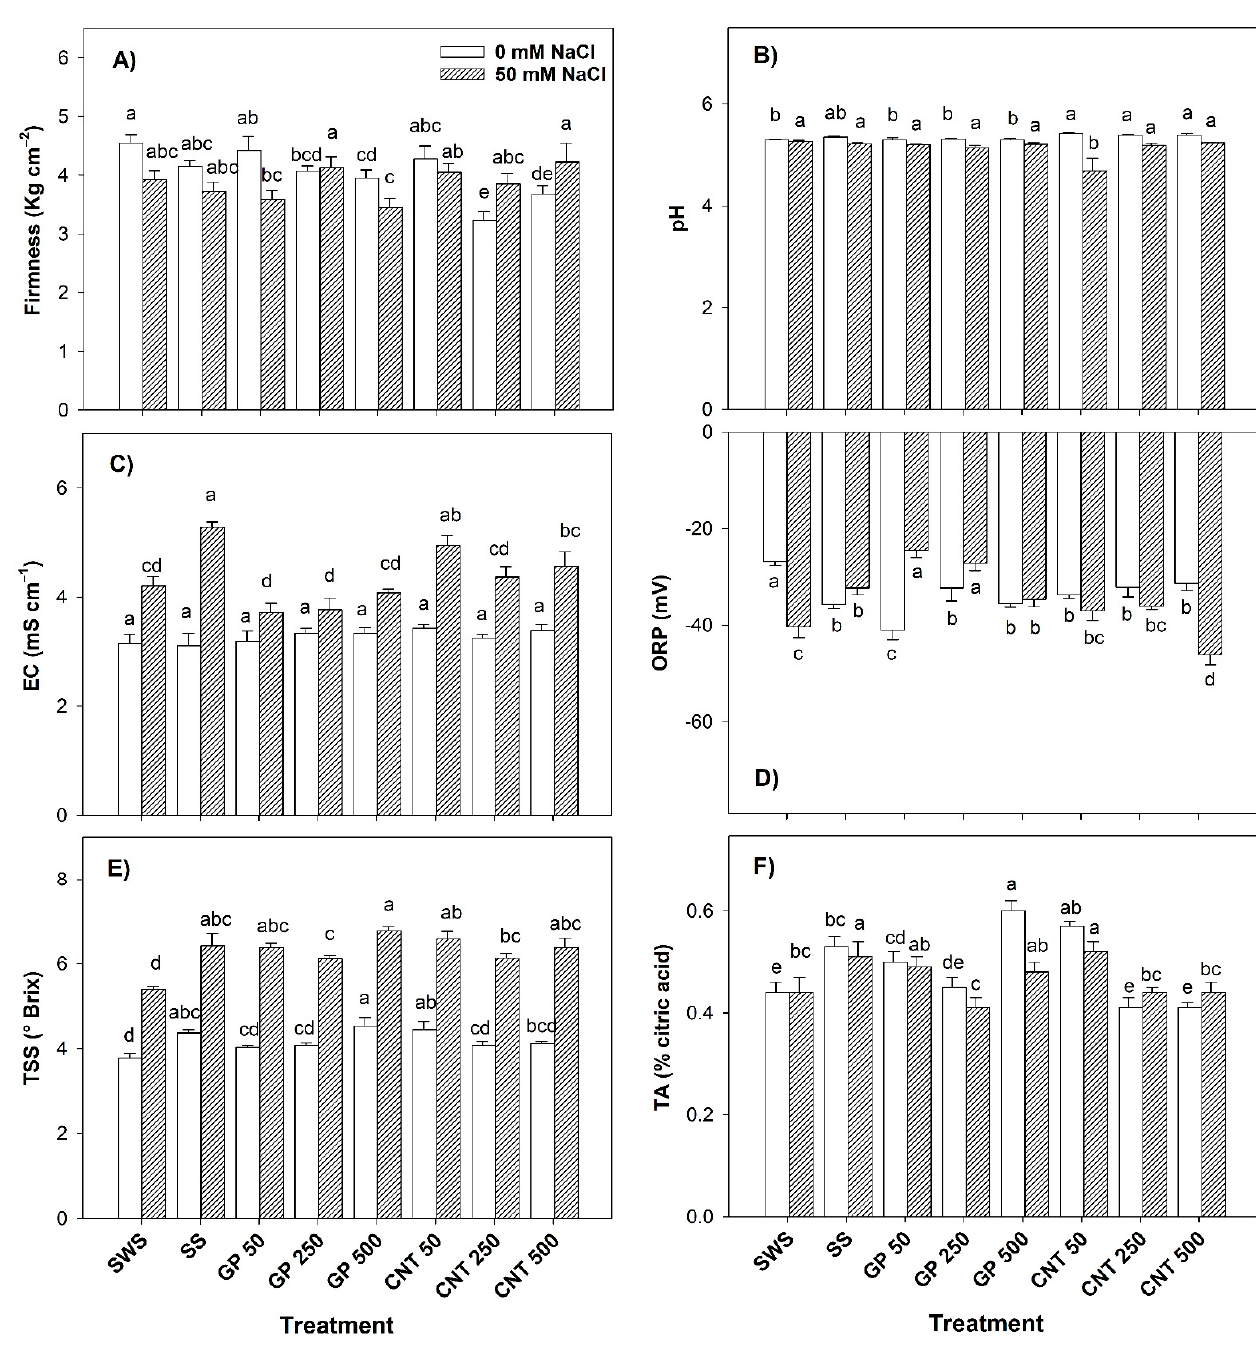
Figure 5. Physico-chemical characteristics of the fruits of tomato plants treated with carbon nano- materials and salinity: A) firmness, B) hydrogen potential (pH), C) electrical conductivity (EC), D) materials and salinity: ( A ) firmness, ( B ) hydrogen potential (pH), ( C ) electrical conductivity (EC), oxidation-reduction potential (ORP), E) total soluble solids (TSS), and F) titratable acidity (TA). SWS: ( D ) oxidation-reduction potential (ORP), ( E ) total soluble solids (TSS), and ( F ) titratable acidity (TA). non-sonicated seeds; SS: sonicated seeds; GP: graphene; CNT: carbon nanotubes; 50, 250, and 500 SWS: non-sonicated seeds; SS: sonicated seeds; GP: graphene; CNT: carbon nanotubes; 50, 250, and represent the mg L − 1 applied of carbon nanomaterial. Different letters indicate a significant differ- 500 represent the mg L − 1 applied of carbon nanomaterial. Different letters indicate a significant ence between treatments according to Fisher ( α = 0.05). n = 6 ± standard error. difference between treatments according to Fisher ( α = 0.05). n = 6 ± standard